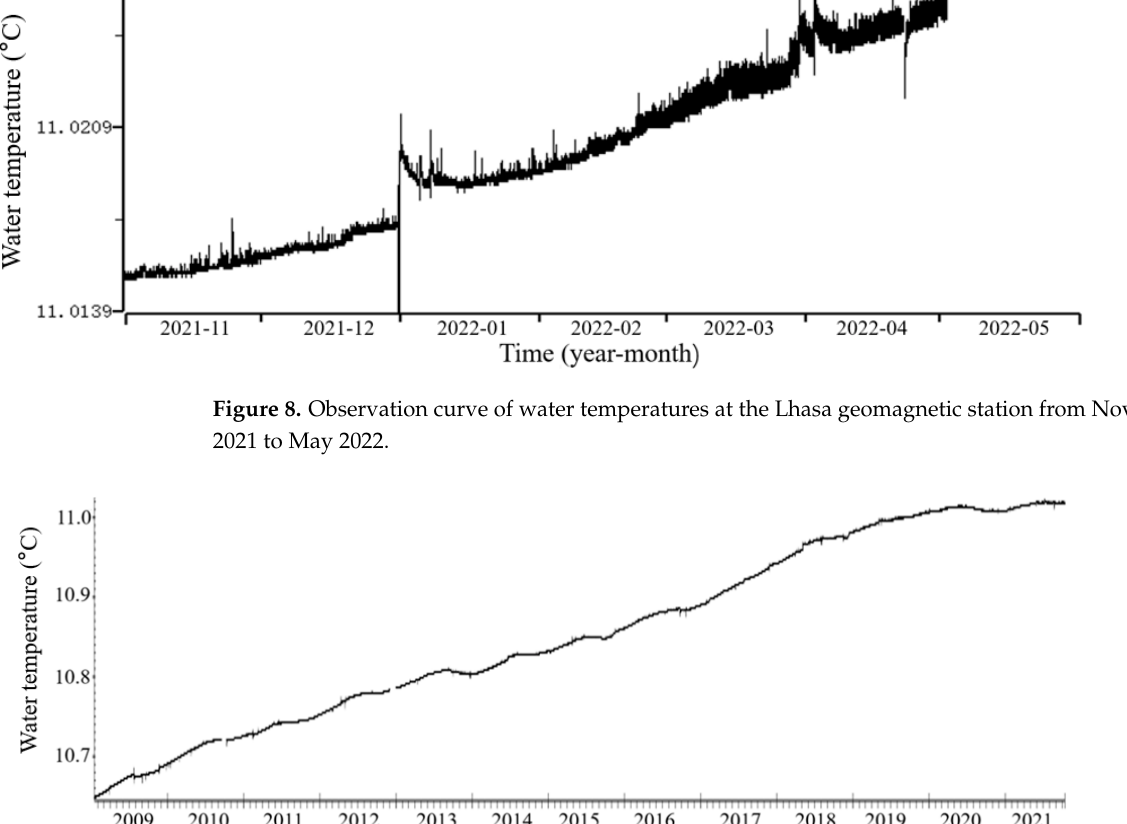
Figure 10. Long-term observation curve of the static water level (unit: m) at the Lhasa geomagnetic station. 5. Conclusions Although it is currently a single well, as the world’s rare highest altitude (>3500 m) and well-equipped well water level and temperature observation system, and as the fron- tier of geodynamics research on the Tibetan Plateau, our data from the Lhasa station will undoubtedly be of great reference value to other research colleagues (both within China and worldwide). By analyzing the responses of the water temperature and water level at